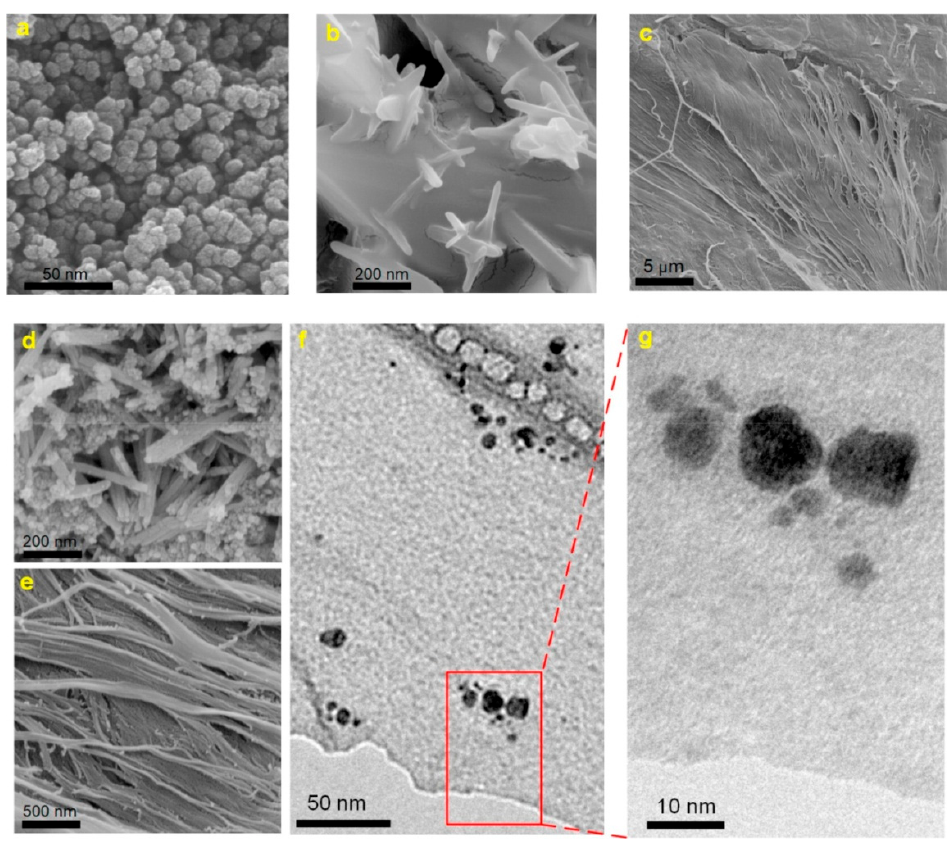
Figure 8. FE-SEM images of ( a ) Fe 3 O 4 NPs, ( b , c ) CNC-PCA and ( d , e ) CNC-PCA/Fe 3 O 4 hybrids, ( f , g ) TEM images of CNC-PCA/Fe 3 O 4 hybrids [104].